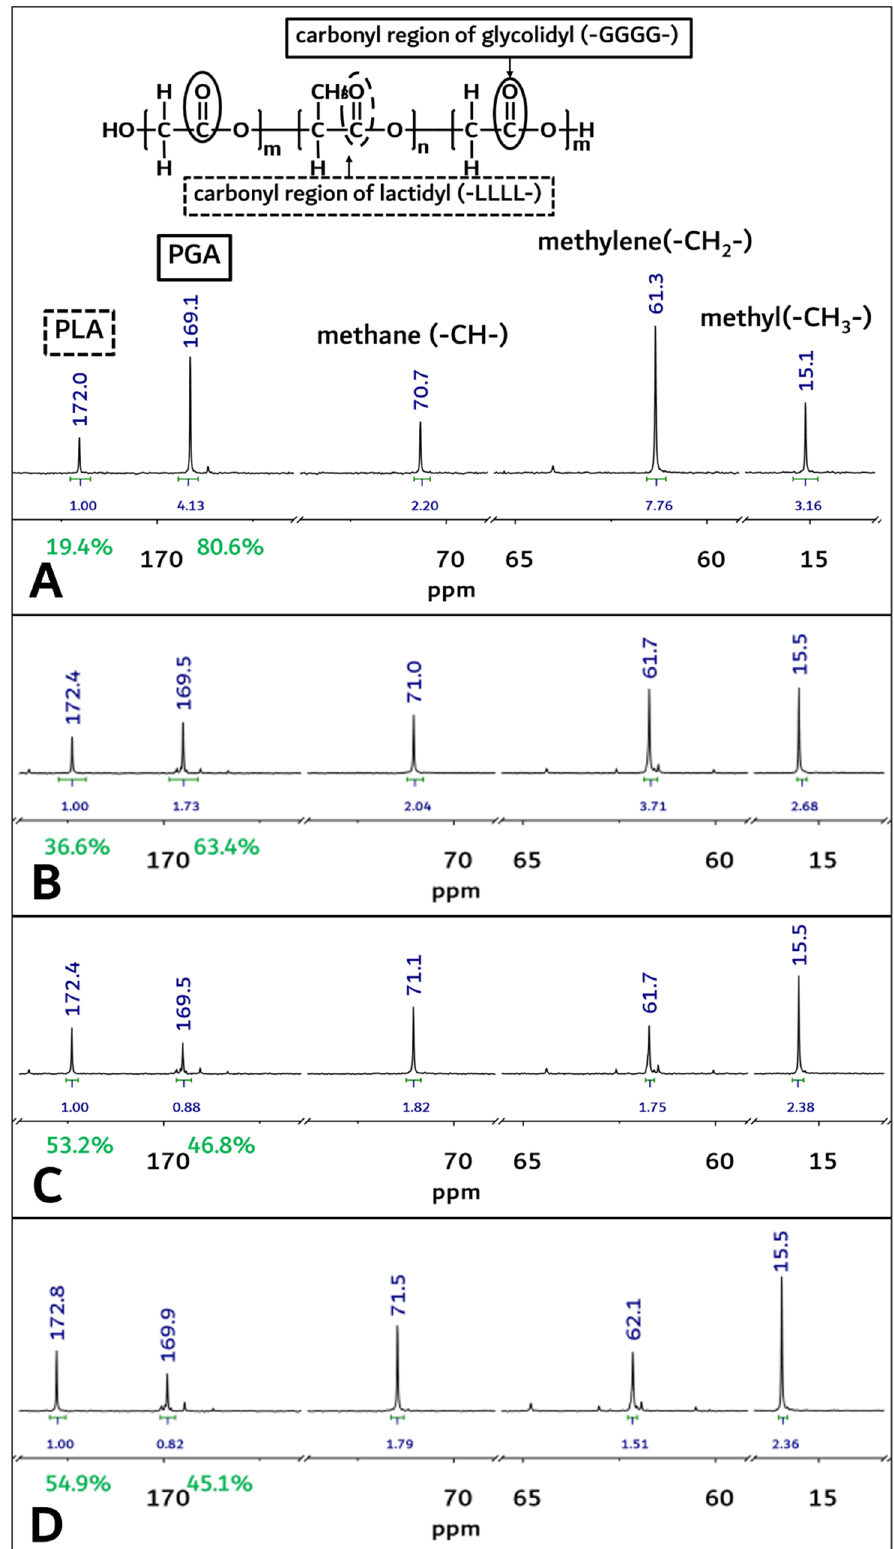
Figure 4. The 13 C-NMR spectra of PGA–PLA block copolymer. (solvent: Trifluoroacetic acid-d, ( A ) Original sample’s spectra before implantation, ( B ) 1-month sample’s spectra after surgery, ( C ) 2-month sample’s spectra after surgery, ( D ) 3-month sample’s spectra after surgery).